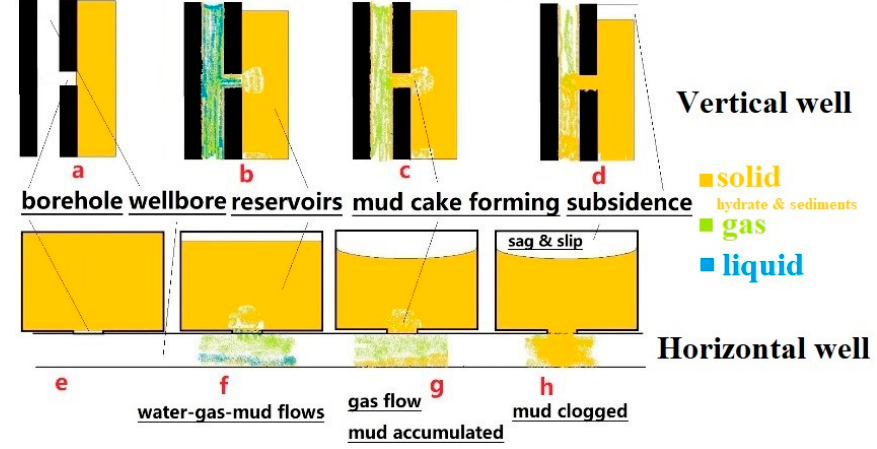
Figure 8. Production schematics of horizontal and vertical silty-clay wells: ( a ) a vertical well in hydrate-bearing sediments; ( b ) the first production period of a hydrate vertical well; ( c ) the second production period of a hydrate vertical well; ( d ) the third production period of a hydrate vertical well; ( e ) a horizontal well in hydrate-bearing sediments; ( f ) the first production period of a hydrate horizontal well; ( g ) the second production period of a hydrate horizontal well; ( h ) the third production period of a hydrate horizontal well.